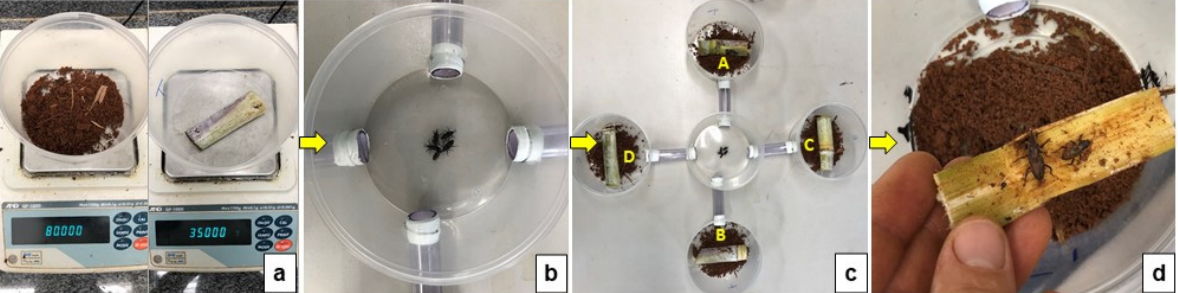
Figure 1. Methodology steps for the insecticide repellency activity including treated soil and sugarcane placement ( a ) in containers; placement of S. levis adults in the central container ( b ); study apparatus with five containers; ( c ) repellency evaluations after 24, 48 and 72 h ( d ).